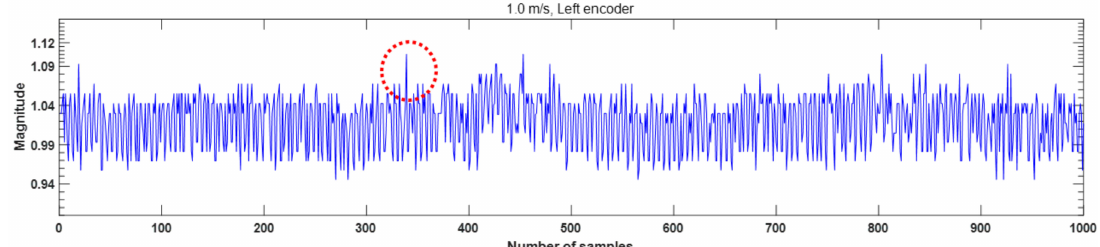
Figure 1. An example of anomalies observed from a left encoder sensor while driving. The red circle indicates one of anomalies which occur during the normal operation (just driving) on the real road, and disappear soon without any damage to the Jackal